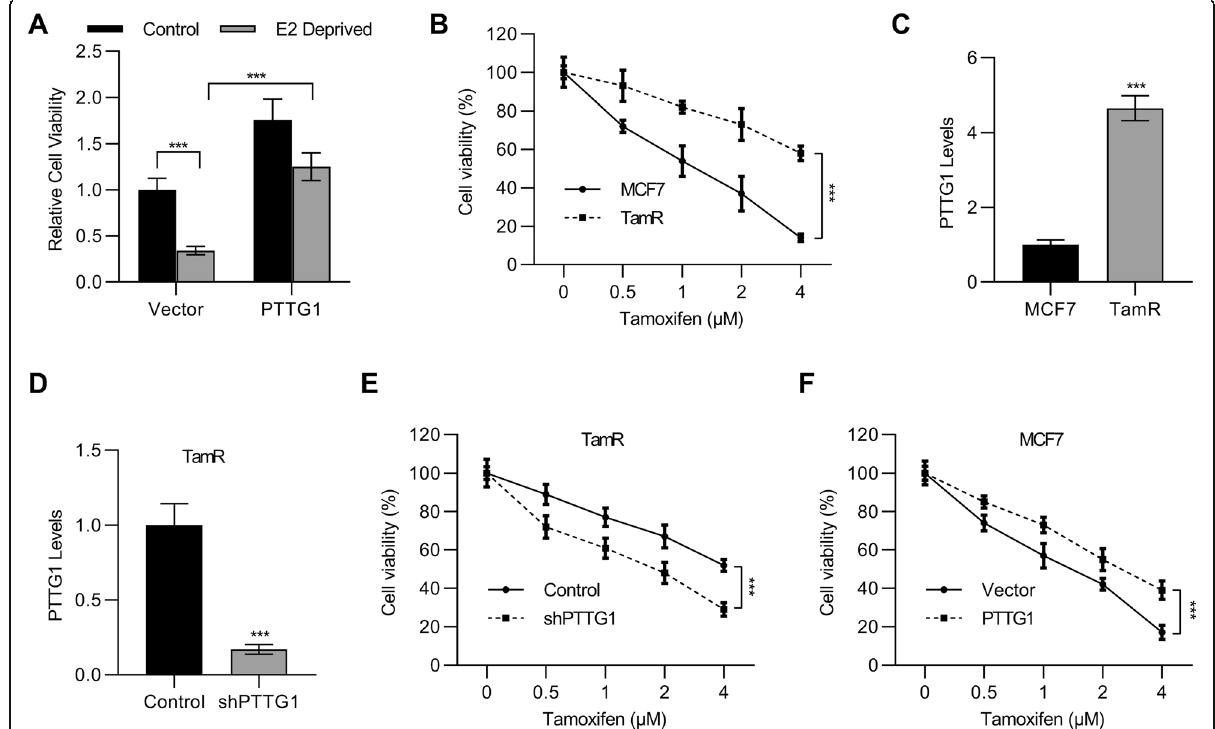
Fig. 4 The levels of PTTG1 were associated with tamoxifen resistance of breast cancer cells. a MTT was used to determine cell viabilities of MCF7 cells that were transfected with vector or plasmids containing PTTG1 sequence. n = 6. b Cell viabilities of MCF7 or tamoxifen resistant (TamR) cells were also determined. n = 6. c-d qPCR was employed to determine the mRNA levels of PTTG1 in the MCF7 cells, TamR cells, and TamR cells that were transfected with shPTTG1 or control shRNA. n = 3. e-f MTT was used to determine the cell viabilities of TamR cells that were transfected with shPTTG1 or control shRNA and MCF7 cells that were transfected with vector or plasmids containing PTTG1 sequence. n = 6. Data were represented as mean ± S.D. *** P <